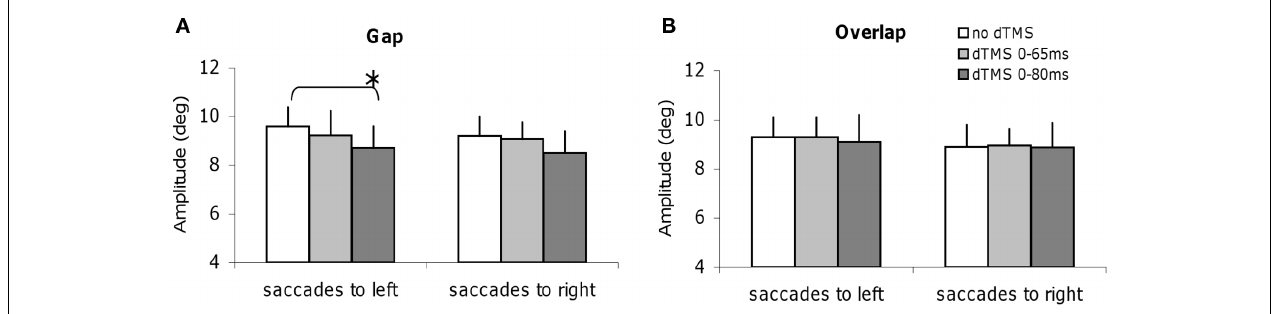
FIGURE 7 | Mean amplitude of saccades with SE for the group subjects in different dTMS conditions: no dTMS, dTMS 0–65ms, dTMS 0–80ms under the tasks gap (A) and overlap (B). Asterisks indicate a significant effect on group mean amplitude of dTMS with an ISI of 65 or 80ms versus control no